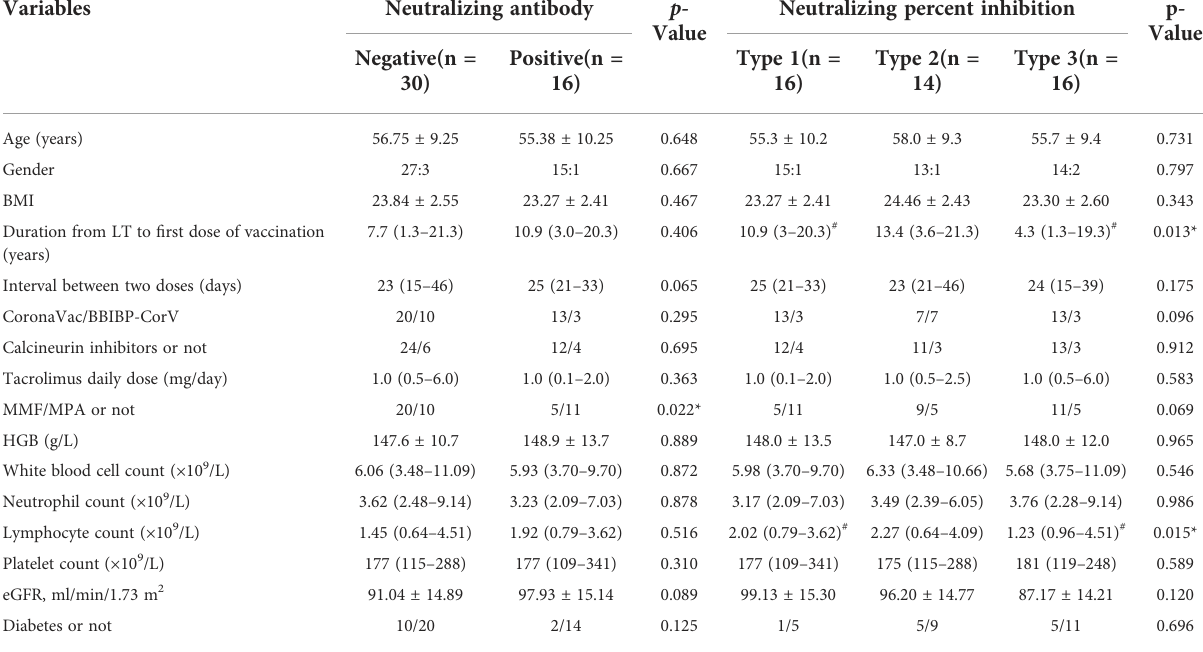
TABLE 2 | Comparison of recipients in neutralizing antibody and neutralizing percent